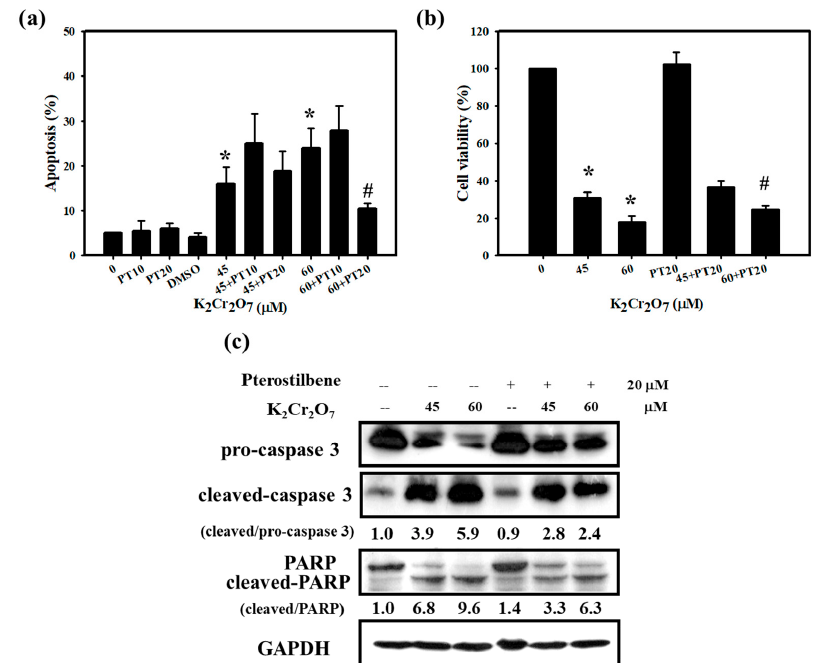
Figure 5. Pretreatment with PT rescued Cr(VI)-induced cytotoxicity. ( a ) HaCaT cells were pretreated with 10 or 20 µ M PT for 1 h. Early apoptosis, detected using an Annexin V apoptosis detection